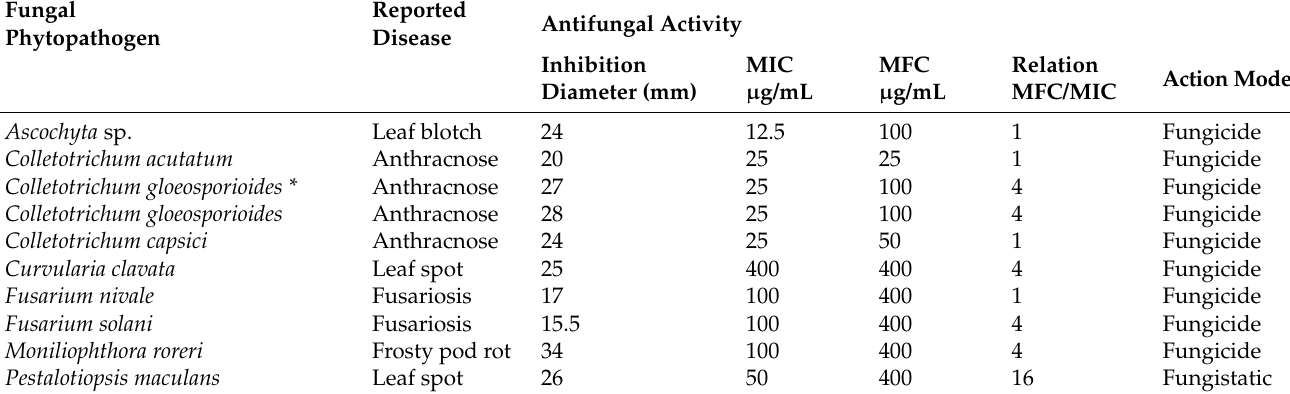
Table 5. Broad-spectrum antifungal activity of crude lipopeptides (CL 84 ) of Bacillus subtilis subsp. spizizenii MC6B-22.